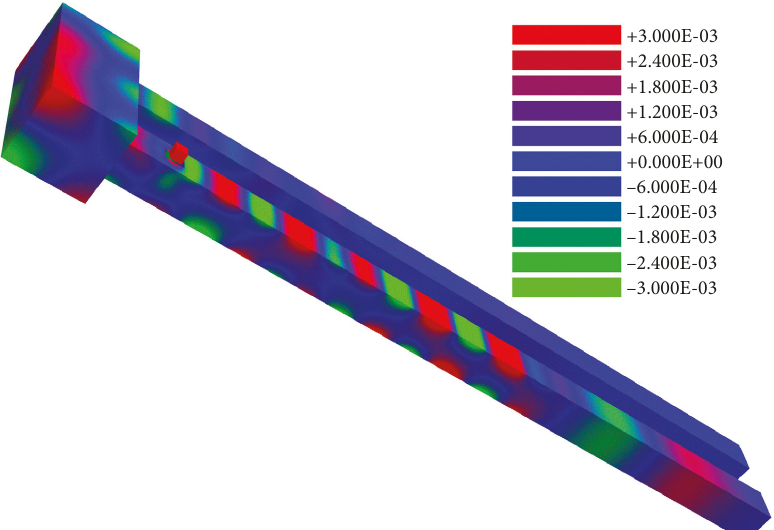
Figure 21: 3D contours of the impact on the concrete block (time t